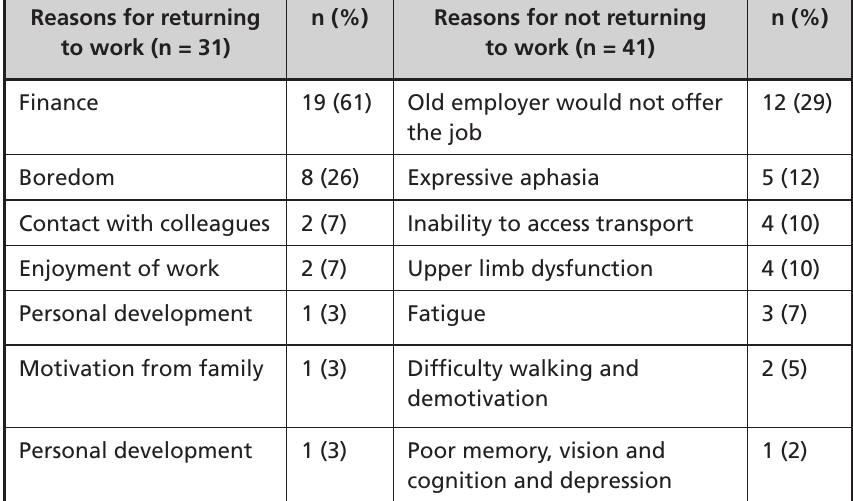
Table 3: The main reasons for RTW and no RTW after stroke Reasons for